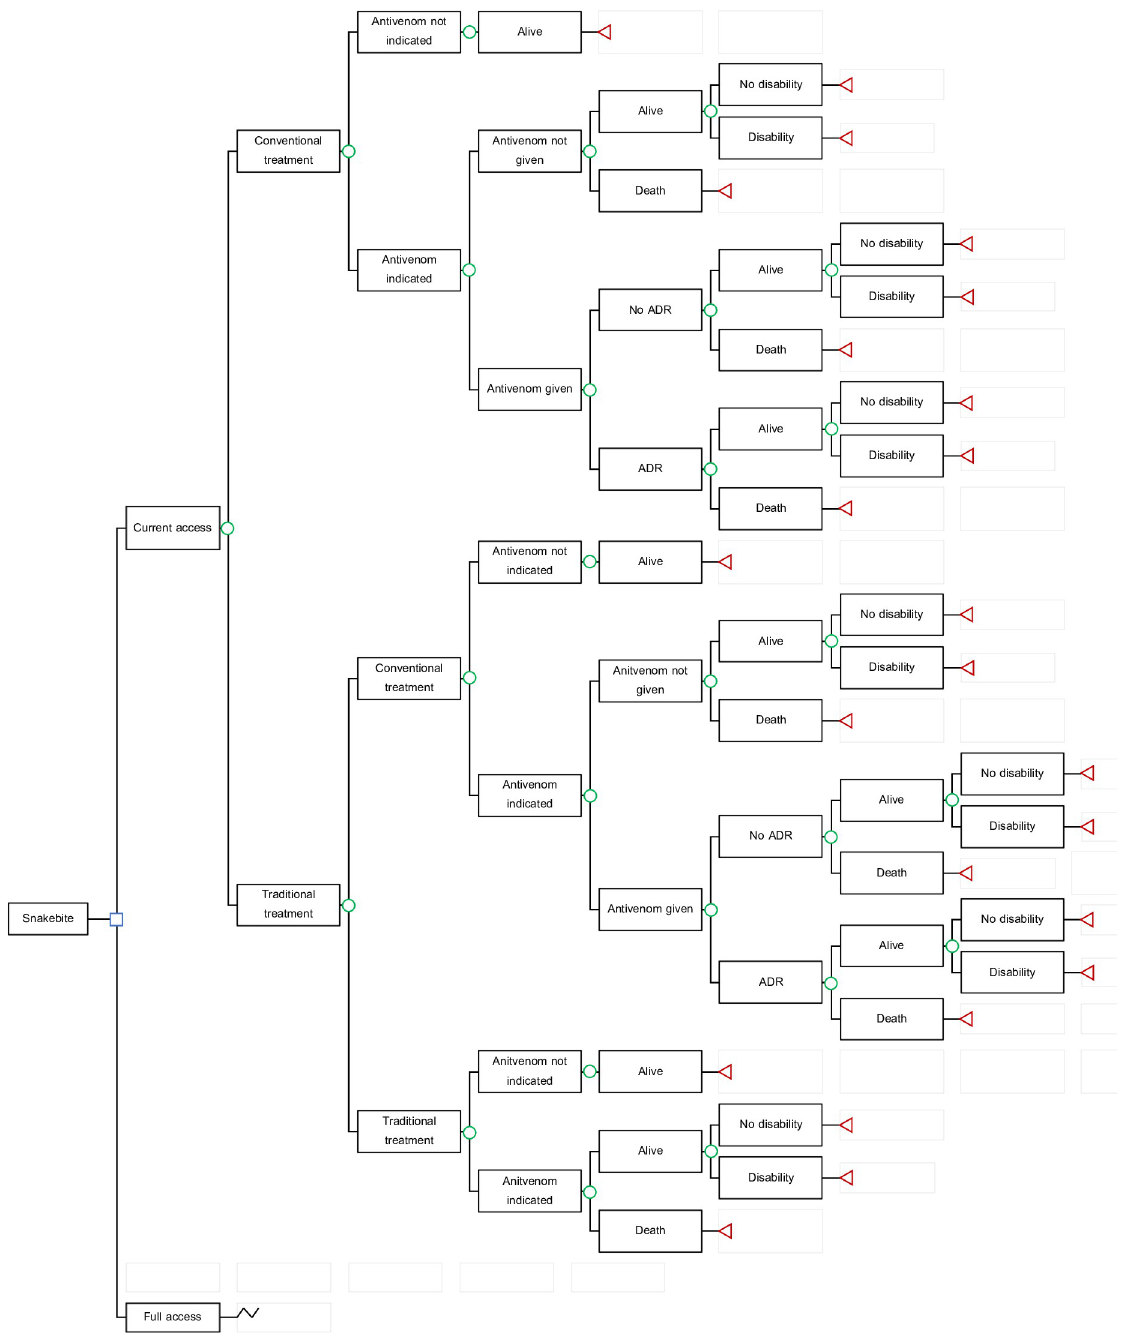
Fig 1. Decision analytic model to estimate economic and disease burden of snakebite in ASEAN countries. Abbreviation: ADR–adverse drug reaction. https://doi.org/10.1371/journal.pntd.0010915.g001 Health outcomes Health outcomes of the model included the number of deaths from snakebite envenoming and disability-adjusted life years (DALYs) lost due to snakebite. DALYs were estimated using the